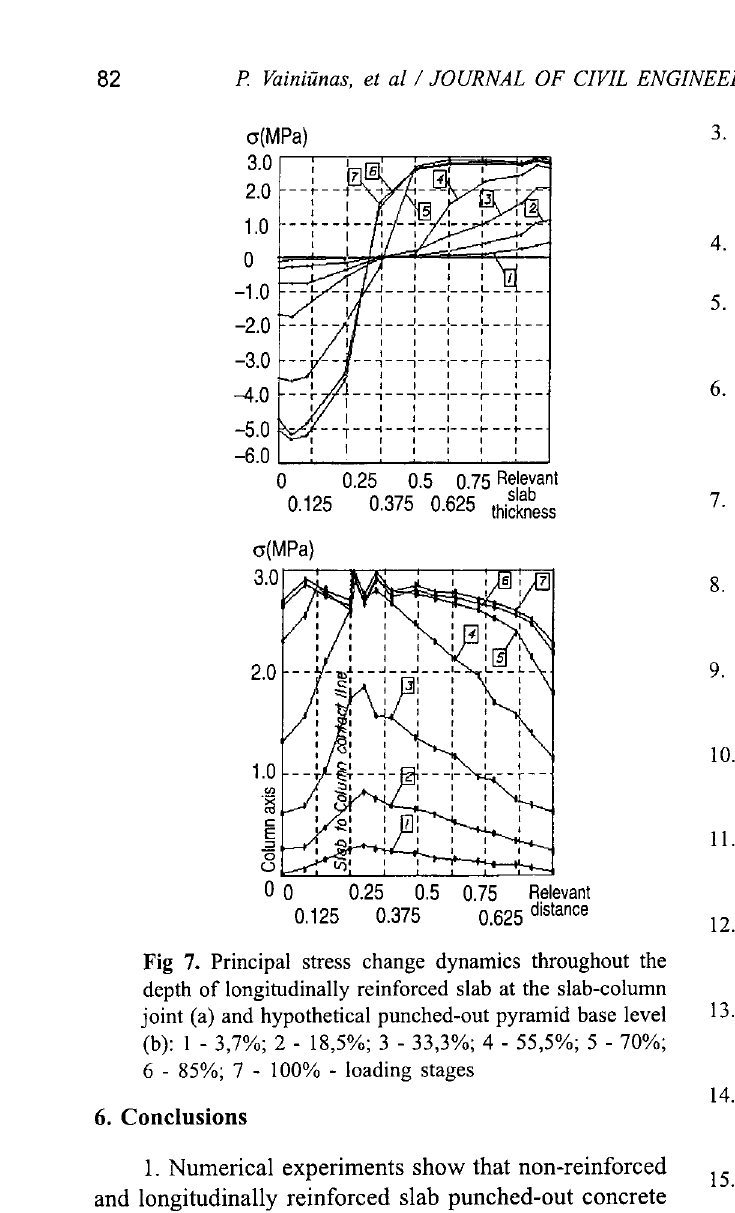
Fig 7. Principal stress change dynamics throughout the depth of longitudinally reinforced slab at the slab-column joint (a) and hypothetical punched-out pyramid base level (b): I - 3,7%; 2- 18,5%; 3 - 33,3%; 4- 55,5%; 5 - 70%; 6 - 85%; 7 - 100% - loading